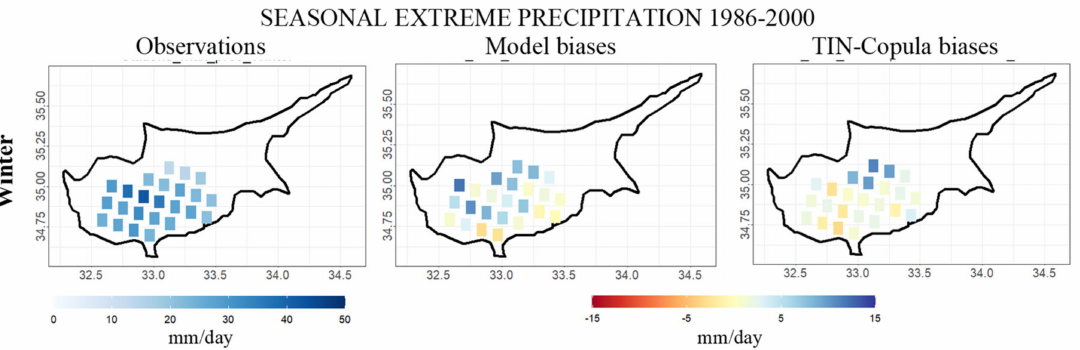
Figure 8. (Left maps) Observed winter extreme precipitation values. (Right maps) Biases between observations and model’s estimations before and after bias correction with the TIN-Copula method.